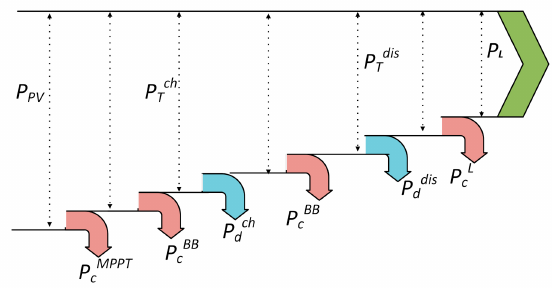
Figure 7. Power flow diagram for distributed generation and central storage